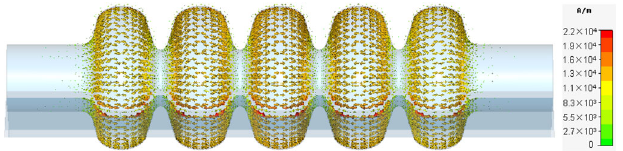
FIG. 8. (Color) Surface current profile of the accelerating (cid:3) mode of the slotted cavity.